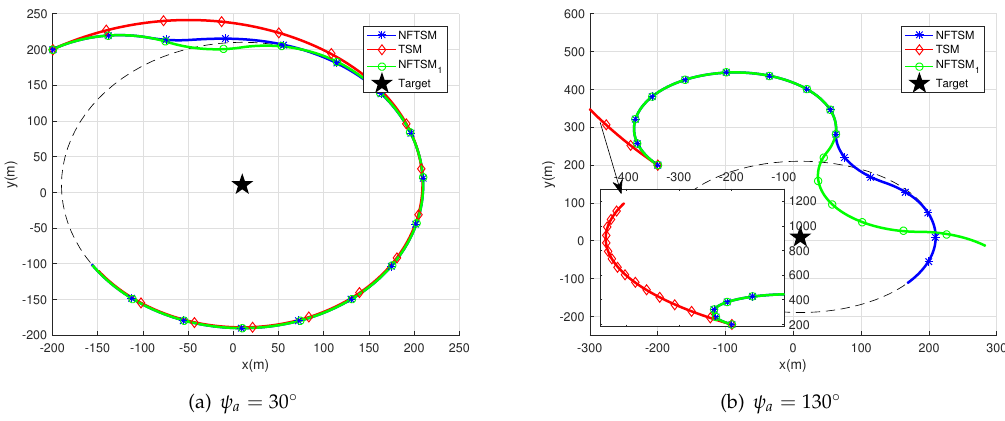
Figure 4. Tracking a stationary target with different initial heading angles.